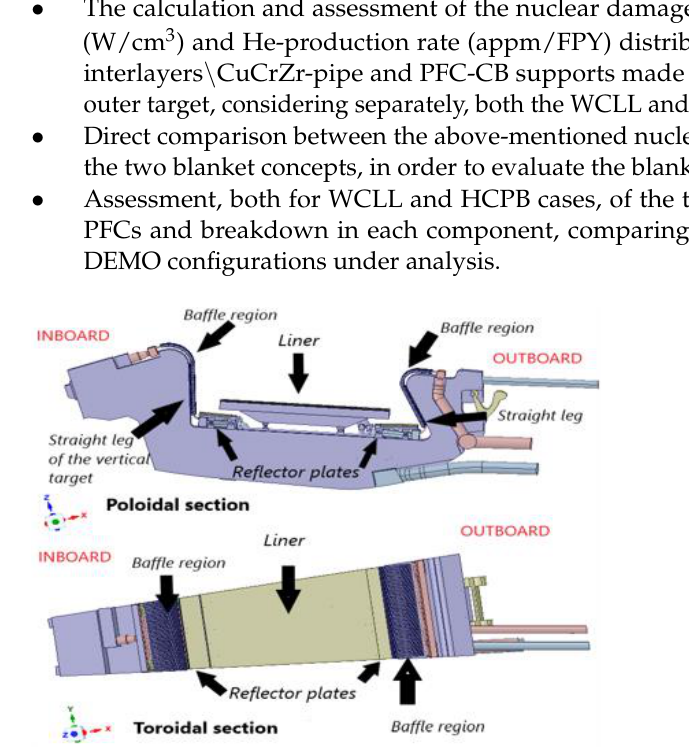
Figure 2. Latest neutronics CAD model of the DEMO divertor cassette body 2019 [25,27].